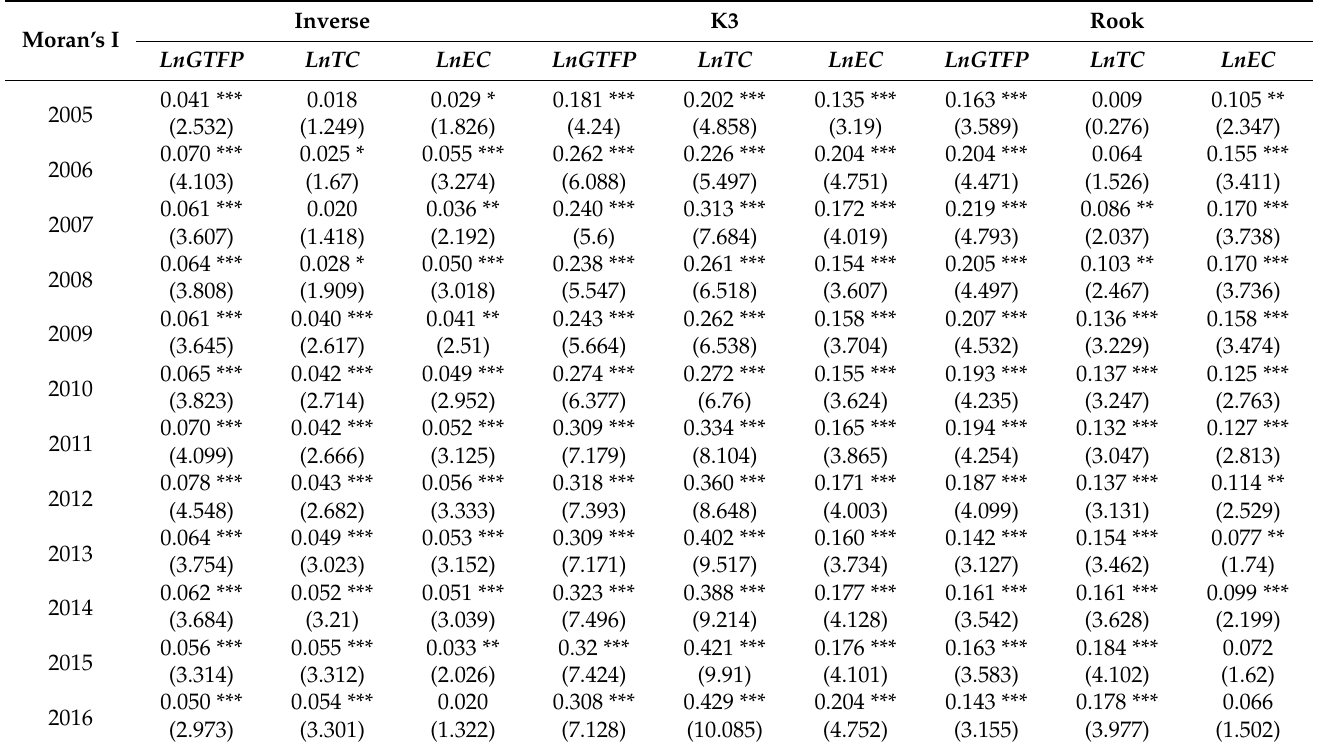
Table 2. Results of Moran’s I test for GTFP, TC and EC scores of Chinese